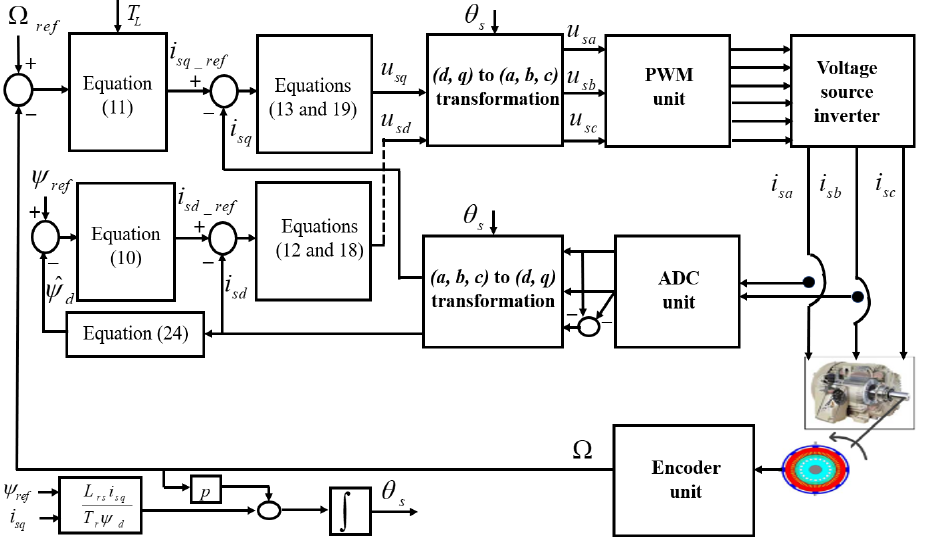
Figure 1. Diagram of the suggested IBS-DISMC.